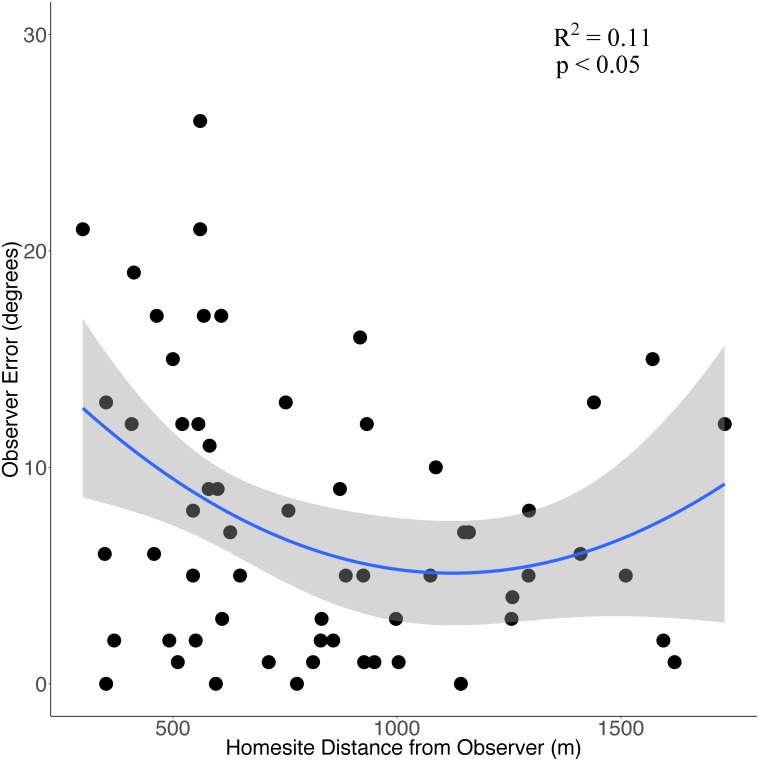
The relationship between observer error and distance (m) from homesites when conducting howl surveys of wolf homesites during June-August in the Greater Voyageurs Ecosystem.Observer error is the difference (in degrees) between an observer’s estimated bearing of a wolf response and the true bearing of the homesite. The solid blue line represents the quadratic relationship between observer error and distance from homesites and the shaded region represents the 95% confidence interval.